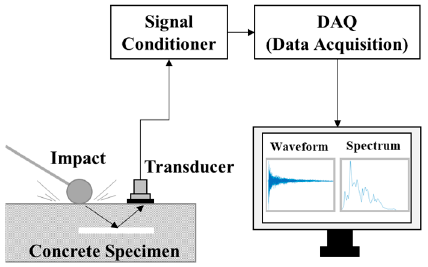
Figure 1. Schematic of Impact-Echo